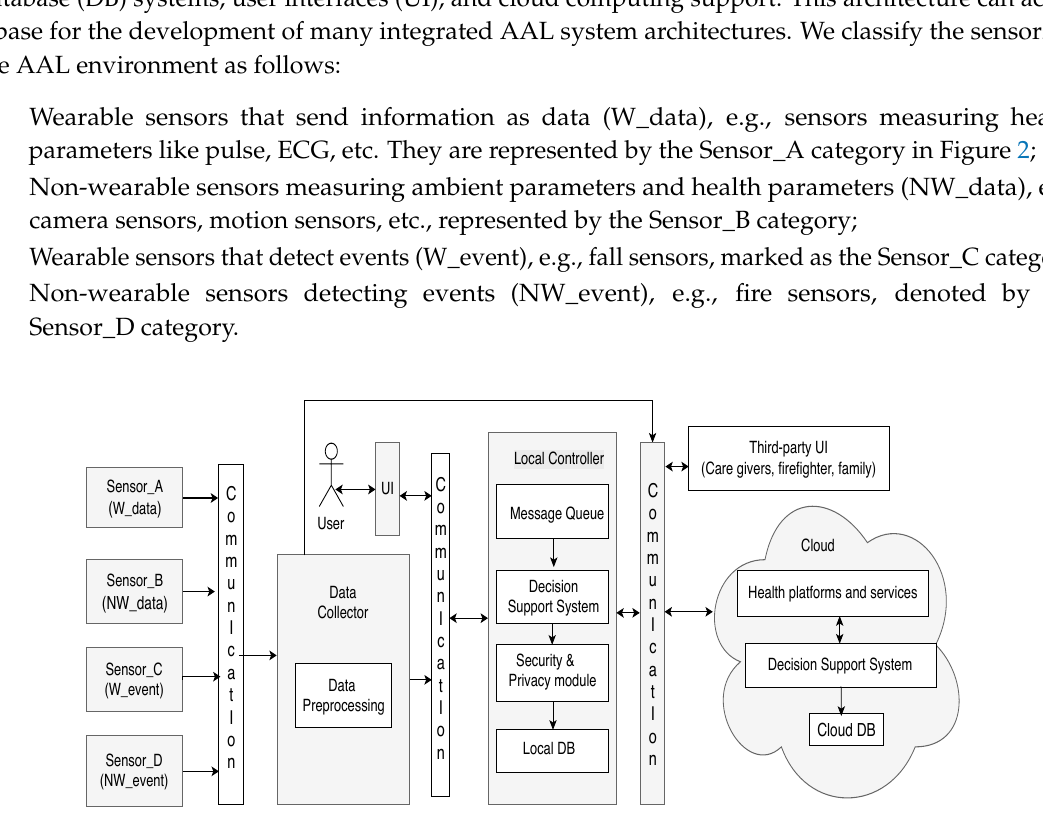
Figure 2. The generic Ambient Assisted Living system